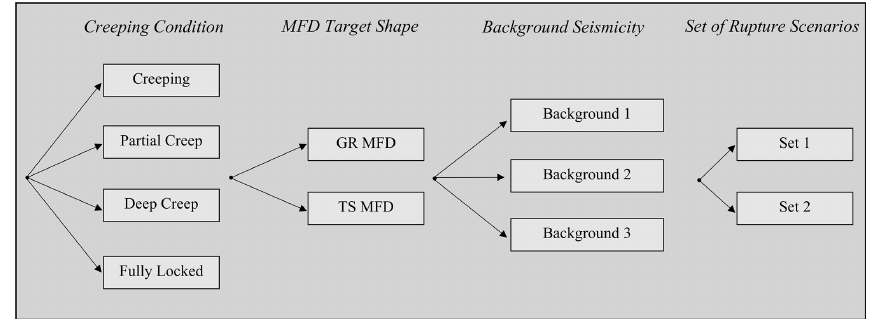
Figure 6. Logic tree explored in this study. For each branch, the scaling law parameters and the slip-rate uncertainties are explored through 10 random samples.